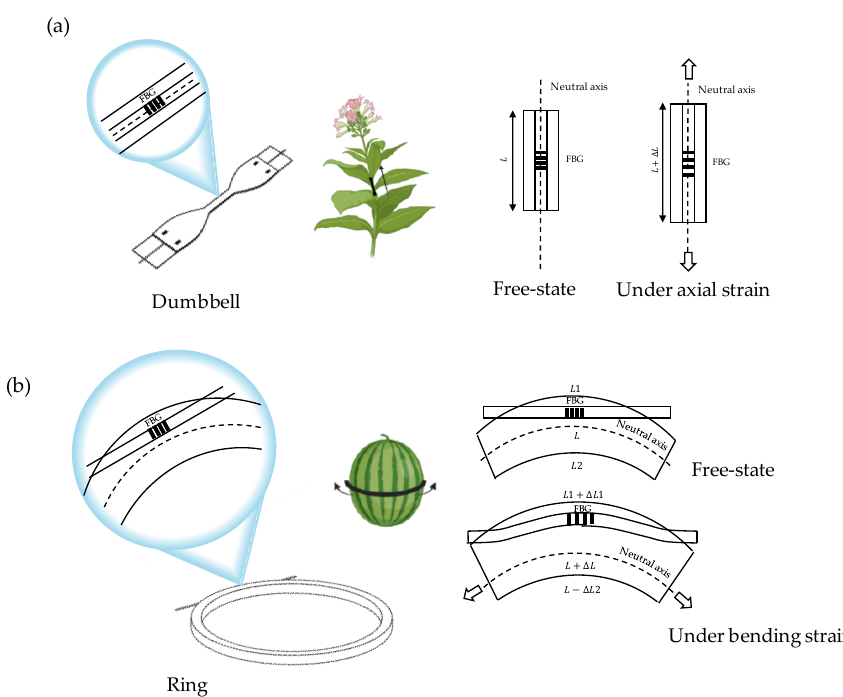
Figure 2. The two shapes of the proposed plant wearables for in-length ( a ) and in-width ( b ) growth monitoring.